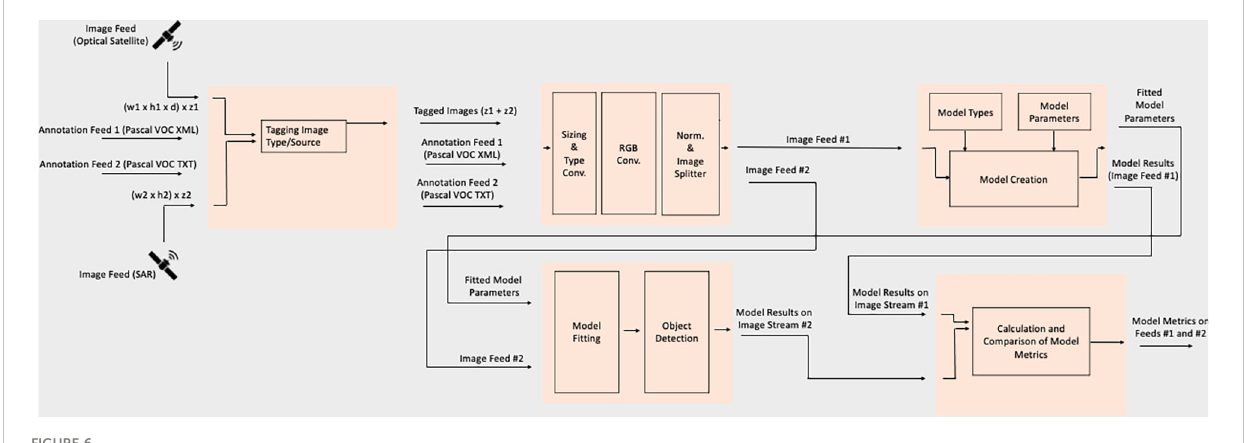
FIGURE 6 System Block